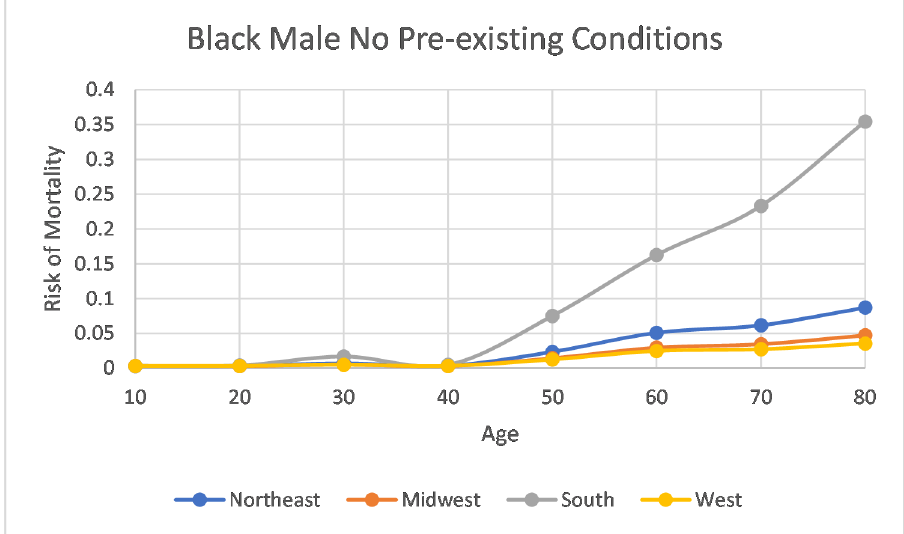
Figure 8. Probability of mortality for a black male with no pre-existing conditions for certain age groups. Given as a decimal. Same information as in Table